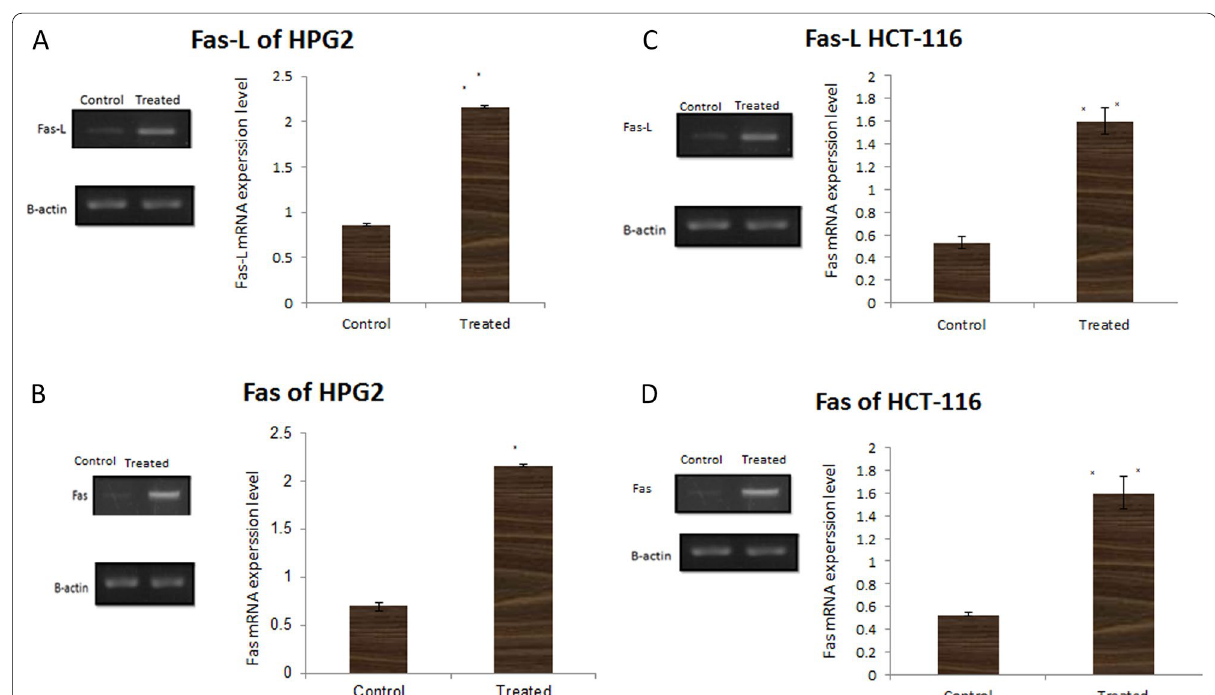
Fig. 4 PCR detected the expression of Fas‑L and Fas in HepG2 and HCT‑116 cells after treatment with NSP where the internal control expressed by the β‑actin gene. In each illustrative experiment data represent means (P <